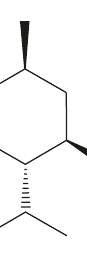
Figure 1: Structure of